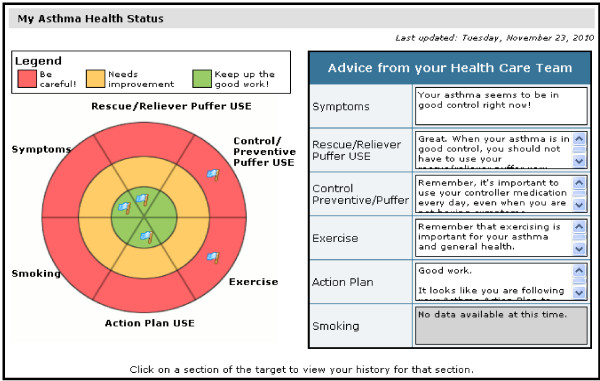
My Asthma Health Profile.